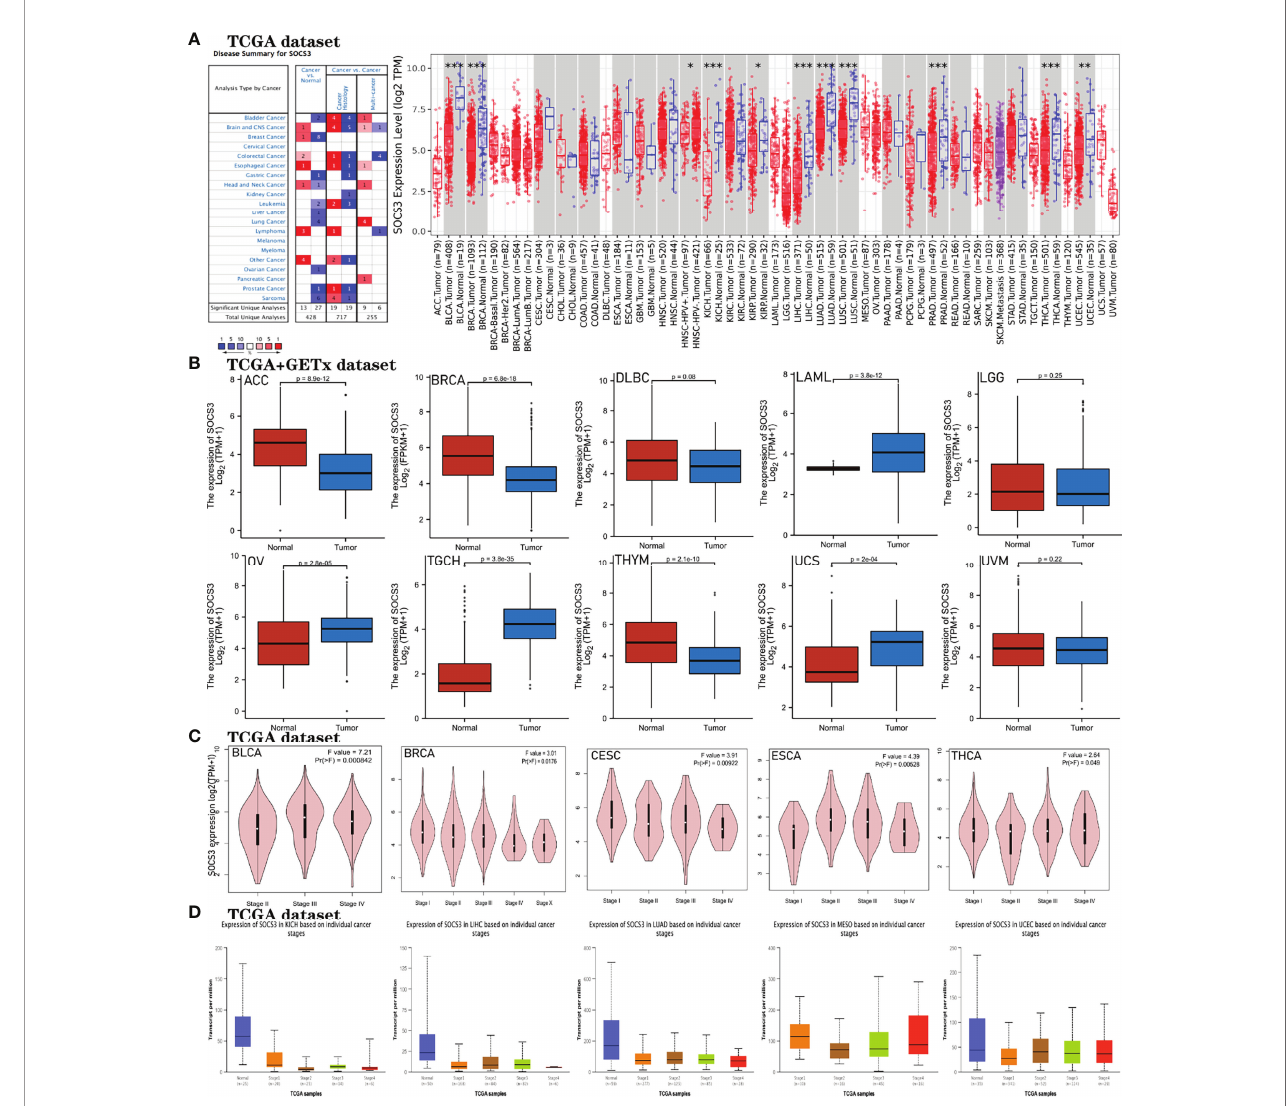
FIGURE 3 | Expression of SOCS3 in disparate cancers and pathological stages. (A) Expression of SOCS3 mRNA in disparate kinds of cancers analyzed with Oncomine and TIMER2.0 databases. Oncomine website: fold change = 2, p-value = 0.01. The value in the fi gure on behalf of the number of datasets that satisfy the threshold. Red and blue indicate the degree of upregulation and downregulation respectively. TIMER2.0: ***p < 0.001, **p < 0.01, *p < 0.05. (B) Expression of SOCS3 mRNA levels in ACC, BRCA, DLBC, LAML, LGG, OV, TGCH, THYM, UCS, and UVM across TCGA cancers, and the corresponding normal samples in the GETx dataset were employed as controls. (C, D) GEPIA2 and UALCAN databases were used to analyze the relationship between pathological stages (stage I, II, III, and IV) of various tumors and SOCS3 expression levels across TCGA data, including BLCA, BRCA, CESC, ESCA, THCA, KICH, LIHC, LUAD, MESO, and